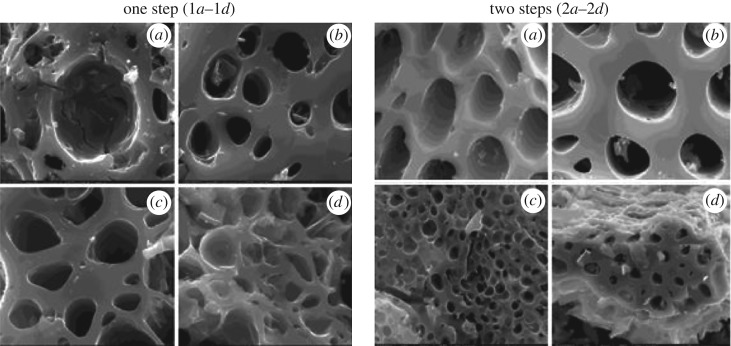
SEM micrographs of carbon samples from CFW, with magnification ×6000: (a) untreated carbon, (b) H3PO4 AC, (c) KOH AC, and (d) ZnCl2 AC.